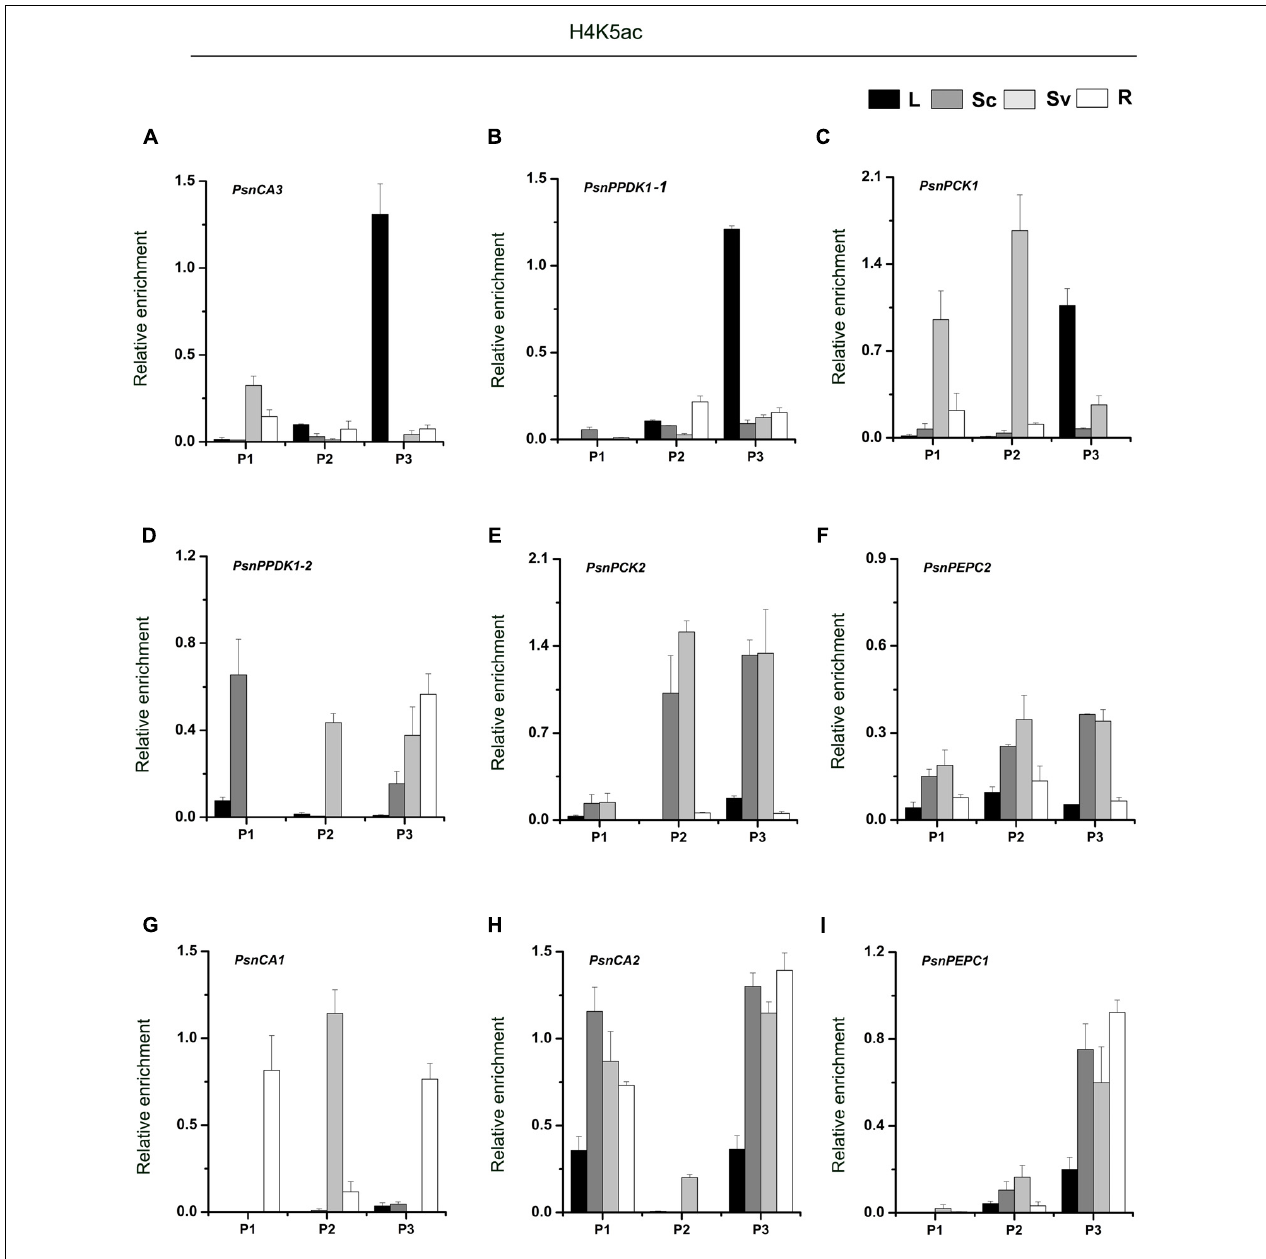
FIGURE 4 | ChIP analysis of the PsnCA , PsnPPDK , PsnPCK , and PsnPEPC gene promoters using the H4K5ac antibody. (A–I) All tissues were harvested from 5-month-old poplar plants grown in a greenhouse 4 h after the onset of illumination. ChIP was used to detect H3K9ac levels in the upstream promoters of the PsnCA , PsnPPDK , PsnPCK , and PsnPEPC genes in leaves (L), stem chlorenchyma (Sc), stem vascular tissue (Sv), and roots (R). P1, P2, and P3 represent the distal, middle, and proximal promoter regions (Supplemental Figure S4). Levels of H3K9ac were standardized by the accumulation of H3K9ac in the promoter of the PsnACTIN2 gene (Supplemental Figure S5). Values are the means from three independent experiments. Bars indicate